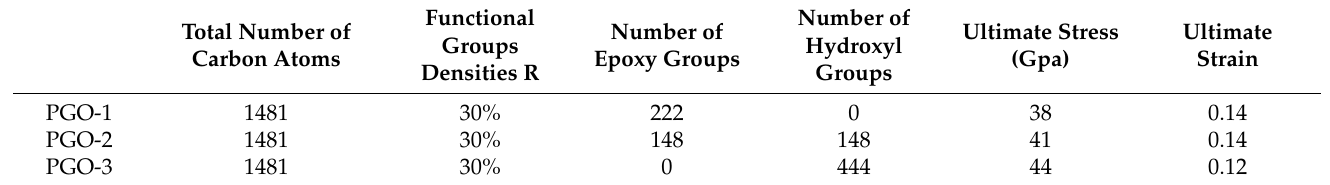
Table 1. Composition of functional groups and uniaxial tensile mechanical properties of PGO model.